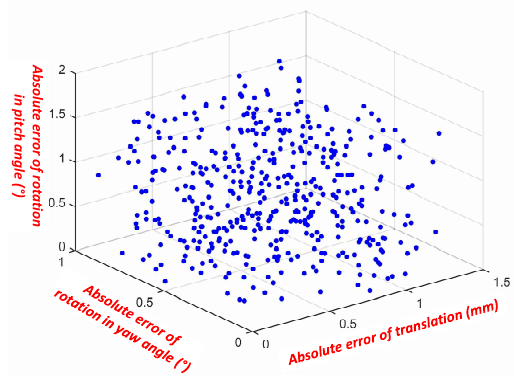
Figure 16. Experimental pose reconstruction errors of flexion-extension (pitch) angle, internal–external (yaw) angle, and mediolateral translation. Table 2. Pose Reconstruction